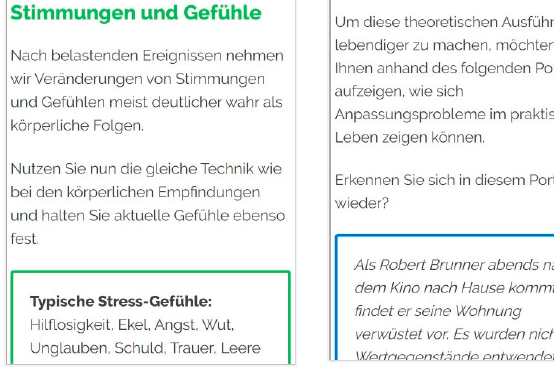
Figure A1. Illustrative Screenshots of the ZIEL Intervention.